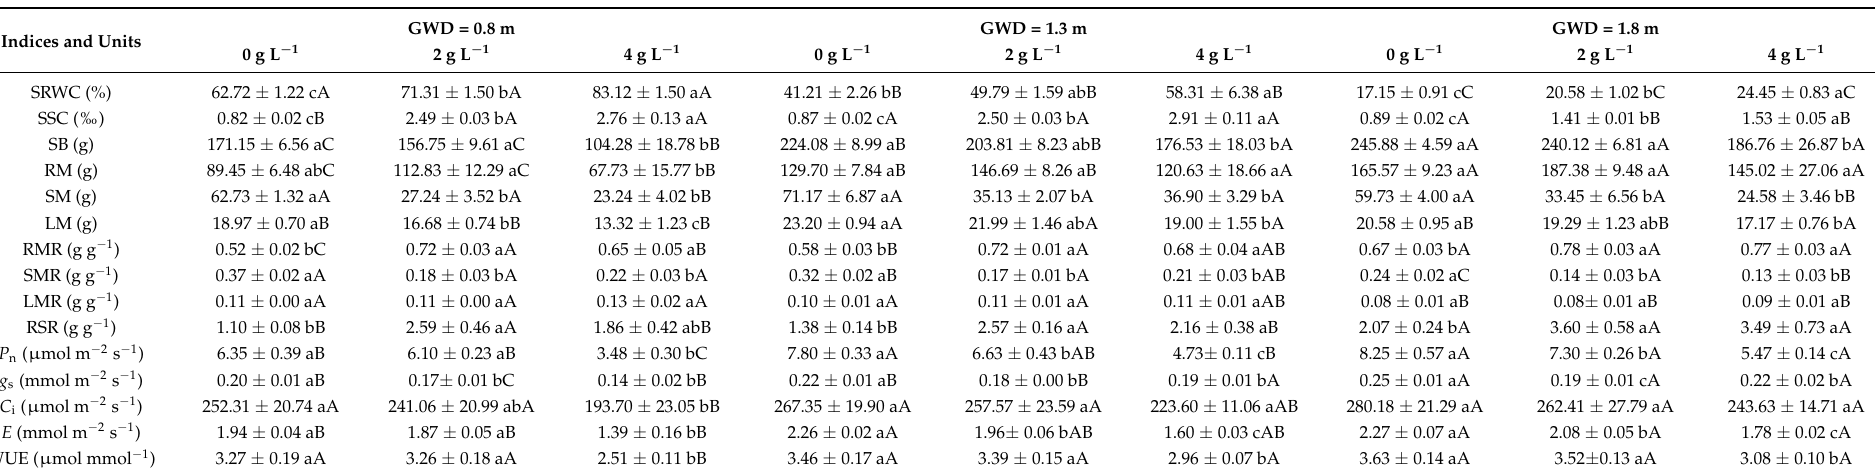
Table A1. Effects of groundwater mineralization and groundwater depth on soil relative water content, soil salt content, and Robinia pseudoacacia characteristics. Indices and